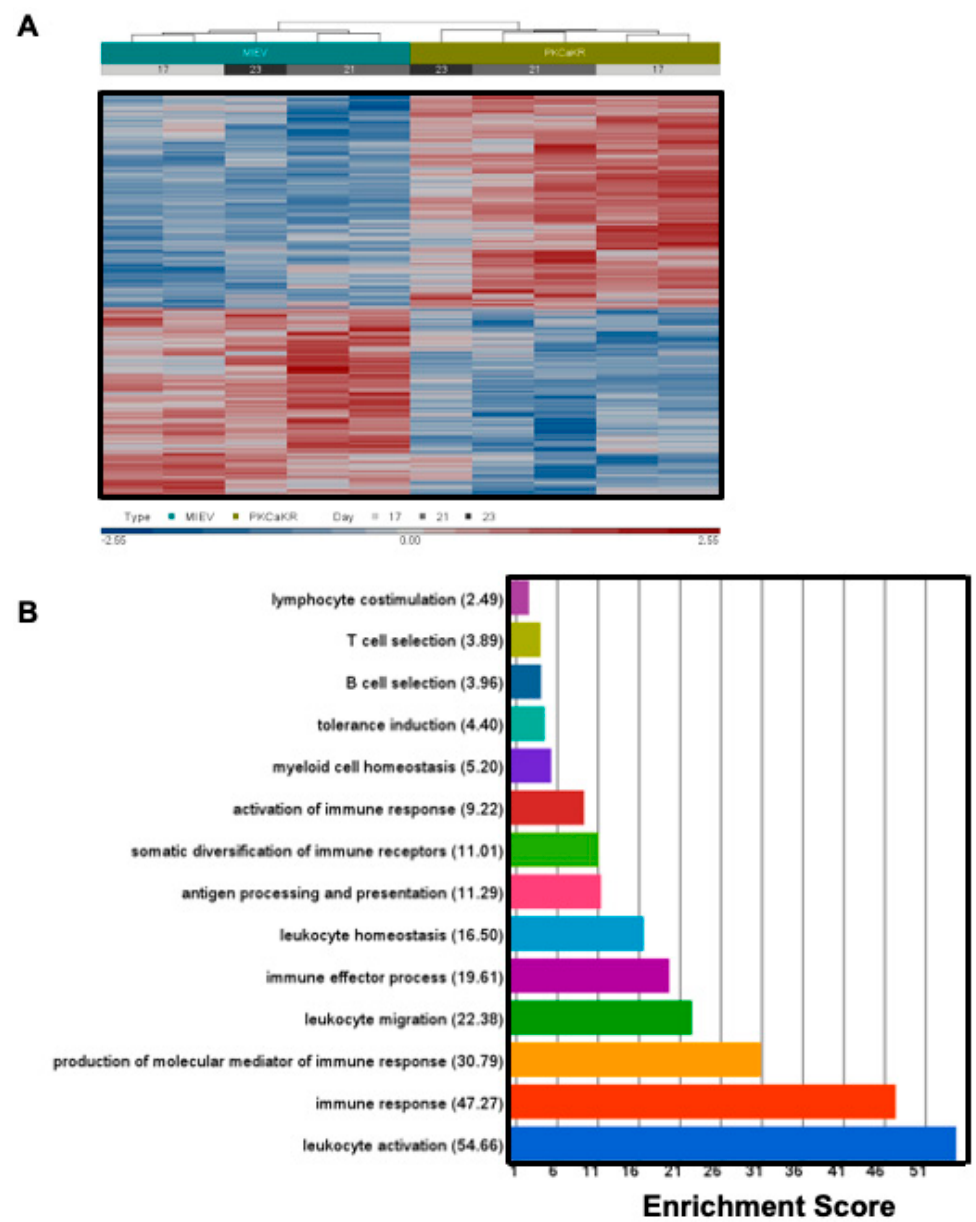
Figure 3. Gene expression comparisons between PKC α -KR vs. MIEV B lineage cells. ( A ) Hierarchical clustering of the relative gene expression using the Euclidian matric with average linkage (Partek Genomics Suite, v6.6) for PKC α -KR vs. MIEV raw Affymetrix files ( n = 5). Culture day for each column identified in grey for both PKC α -KR and MIEV cells (day 17, 21 or 23). ( B ) Gene ontology enrichment analysis of the significantly altered genes (fold change ± 1.2 and p -value < 0.05) between late co-culture PKC α -KR vs. MIEV cells, identified immune system processes as the most enriched groups of pathways. Functional groups with the highest over-representation of genes within the gene list compared to background are shown alongside their respective enrichment score ( − log p -value of a chi-square test).